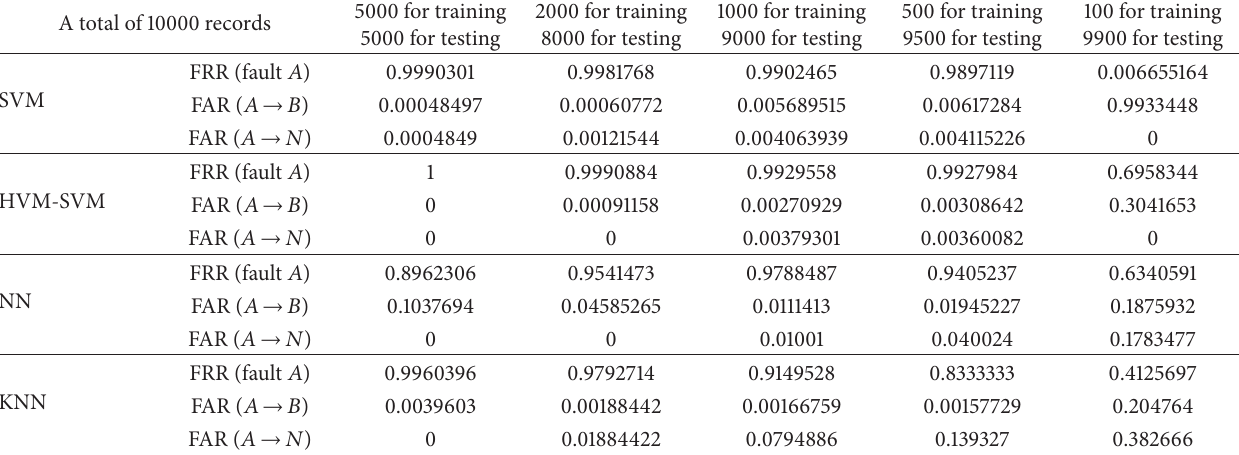
Table 3: The FRR and FAR of HVM-SVM compared with SVM, NN, and KNN (only list parts of the results). A total of 10000